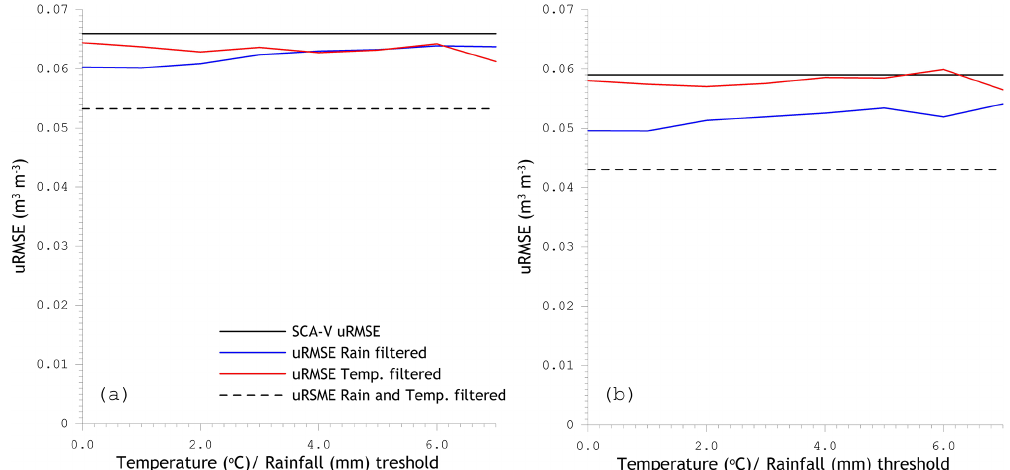
Figure 15. uRMSEs against the daily minimum 1.5m air temperature ( T min ) and rainfall threshold used to filter out matchups for suspected frozen conditions and conditions with an disparity between SMAP’s sensing depth and the depth at which soil moisture is measured. Panel (a) shows the results for the morning estimates and panel (b) the afternoon estimates. The straight line is the uRMSE obtained when matchups are not filtered, and the dashed line is the uRMSE achieved when matchups are filtered on both T min ( < 2 ◦ C) and rainfall